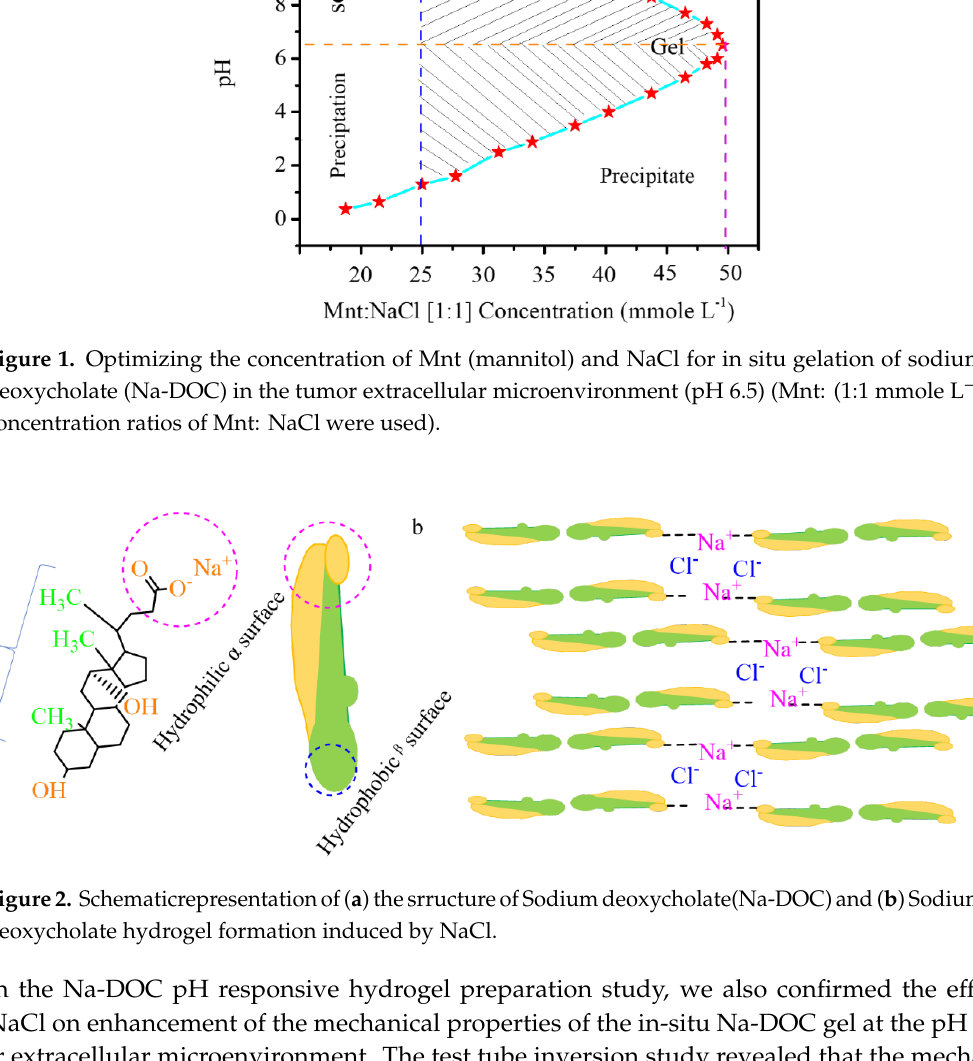
Figure 1. Optimizing the concentration of Mnt (mannitol) and NaCl for in situ gelation of sodium deoxycholate (Na-DOC) in the tumor extracellular microenvironment (pH 6.5) (Mnt: (1:1 mmole L −1 concentration ratios of Mnt: NaCl were used).